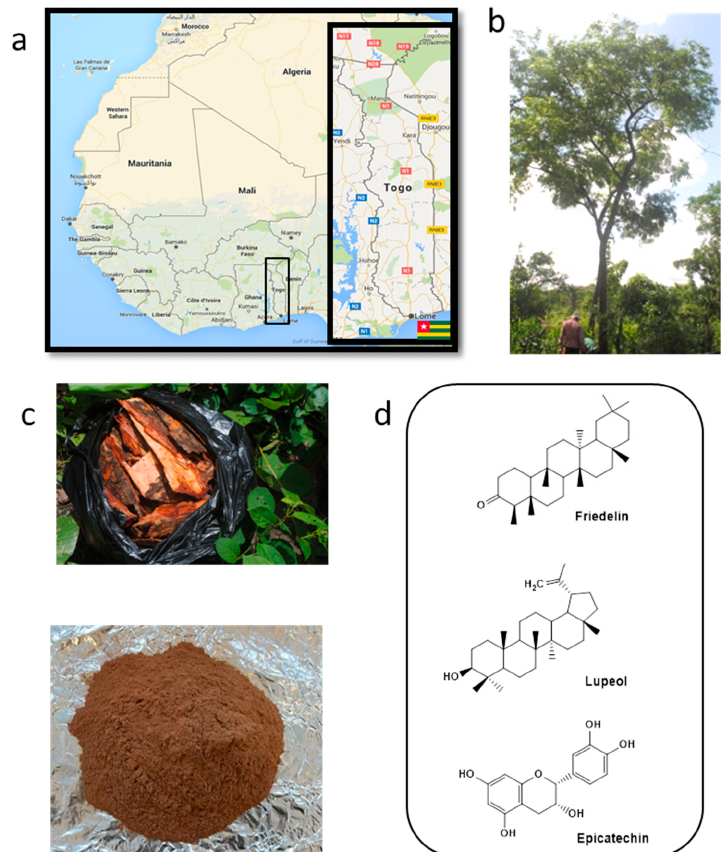
Figure 2. ( a ) Map showing the geographical location of Togo, home of P. erinaceus , in Western Africa; ( b ) P. erinaceus is a common, widespread and particularly rich natural source of many biologically active substances, which unfortunately cannot be used in practice due to difficult handling and low bioavailability; ( c ) Dried and powdered bark of P. erinaceus produced at the University of Lomé from locally collected plant material; ( d ) A brief selection of prominent phytochemicals found in P. erinaceus and responsible for its various biological